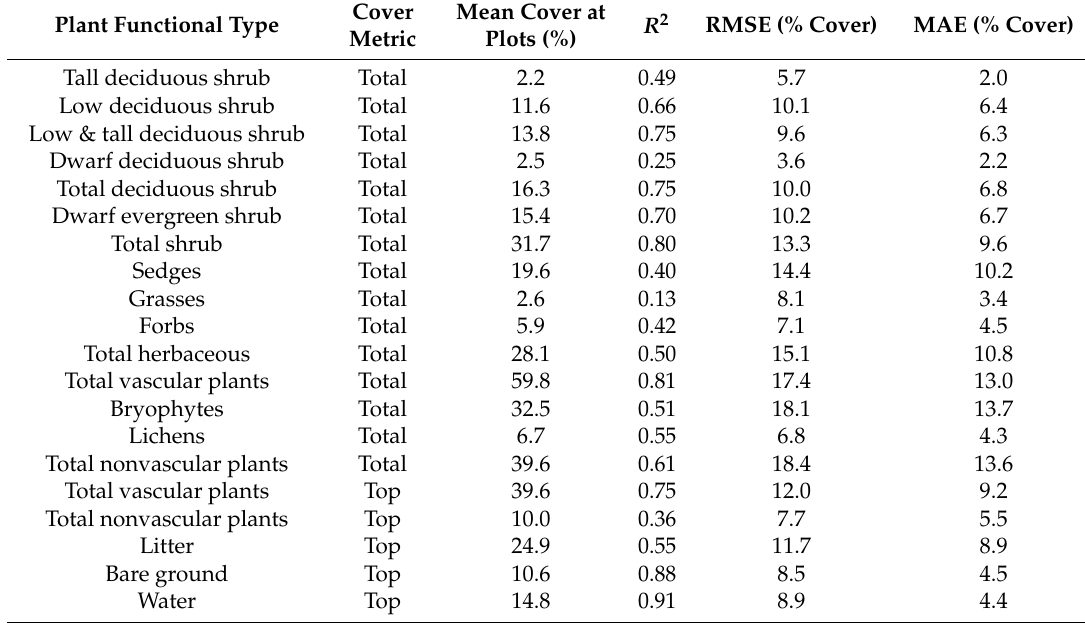
Table 4. Model performance metrics for cover models using full set of 78 predictors, based on internal cross-validation, North Slope,